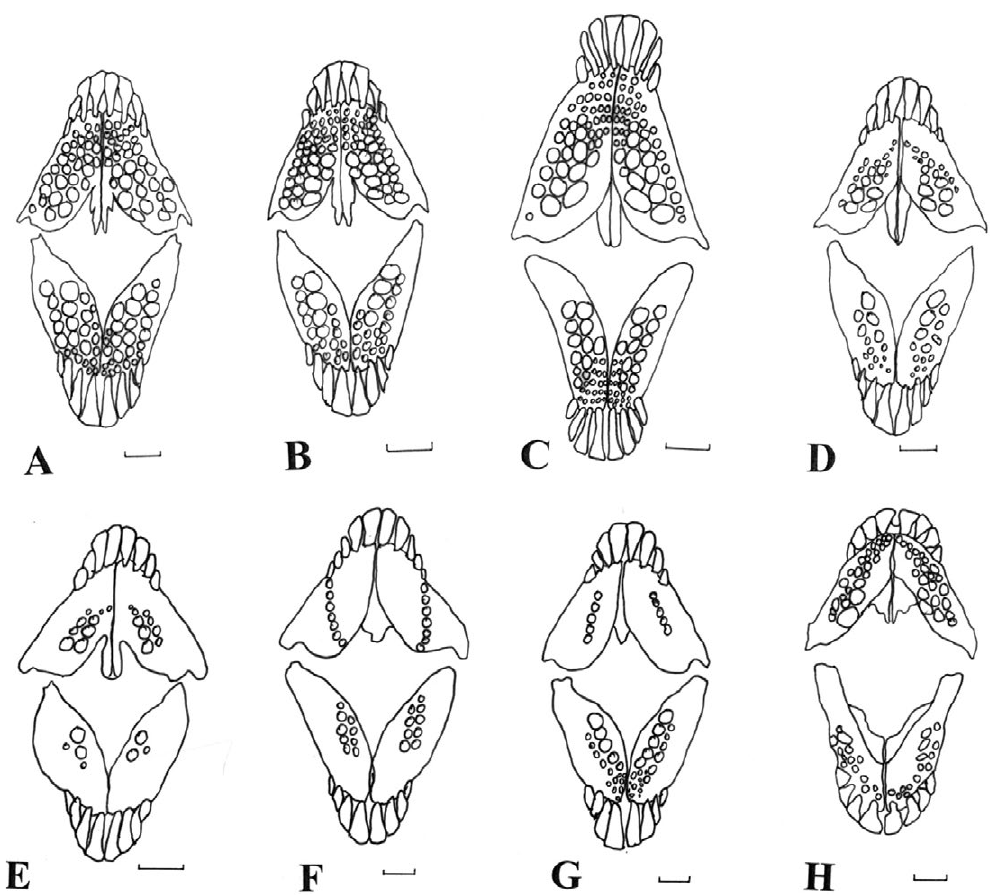
Fig. 6. – Dentition of the species of the eastern Atlantic and Mediterranean species of the Diplodus sargus group and similar species; (above) upper jaw, (below) lower jaw. A , Diplodus sargus , SMNS 9153, specimen 1, 190 mm SL, Croatia, Istria, 9 June 1978. B , Diplodus capensis , SMNS 25672, 1 specimen, 176 mm SL, South Africa. C . Diplodus cadenati , HUJ 20534, specimen 1, 198 mm SL, Senegal, Dakar, Apr. 2015. D , Diplodus levantinus n. sp., HUJ 7462, 1 paratype, 231 mm SL, Israel, Caesarea, 12 Aug. 1959. E , Diplodus lineatus , HUJ 20368, specimen 1, 222 mm SL, Cape Verde Islands, Boa Vista Island, 9 Sept. 2014. F , Diplodus fasciatus , HUJ 20369, specimen 1, 199 mm SL, Cape Verde Islands, Boa Vista Island, 9 Sept. 2014. G , Diplodus prayensis , HUJ 20370, 199 mm SL, Cape Verde Islands, Boa Vista Island, 9 Sept. 2014. H , Diplodus annularis , SMNS 995, specimen 3, 181 mm SL, Italy, Trieste, Dec. 1862. Scales indicate 3